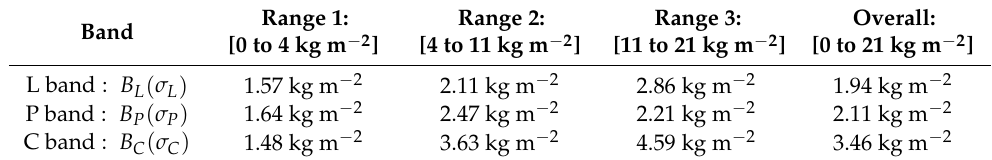
Table 5. RMSE results when evaluating each single-band model in different ranges of AGB. Range 1: Range 2: Band [0 to 4 kg m − 2 ]